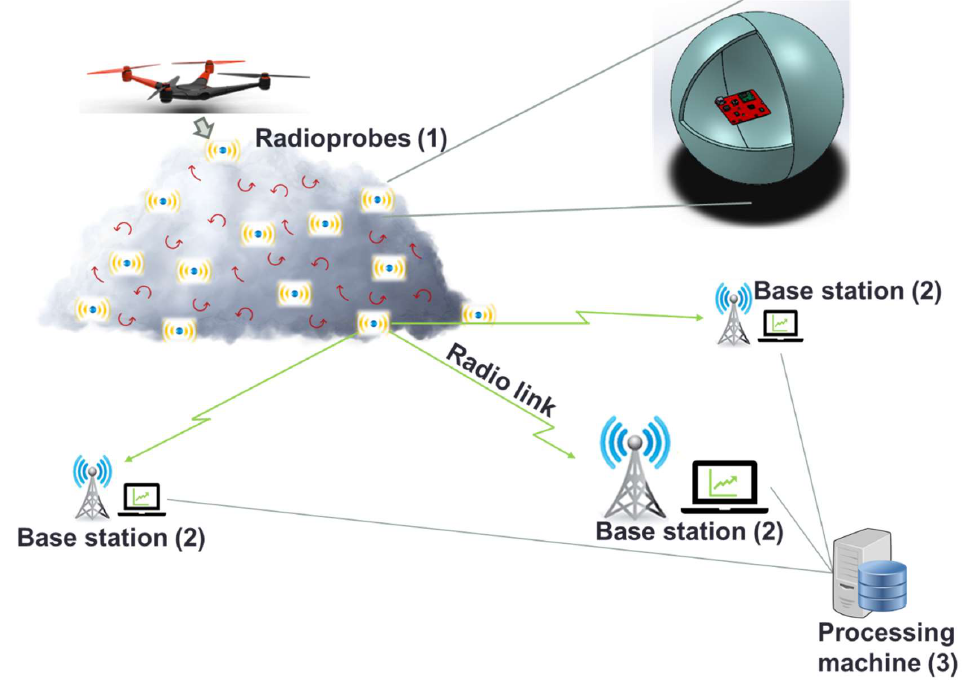
Figure 1. Working principle and radioprobe system architecture.